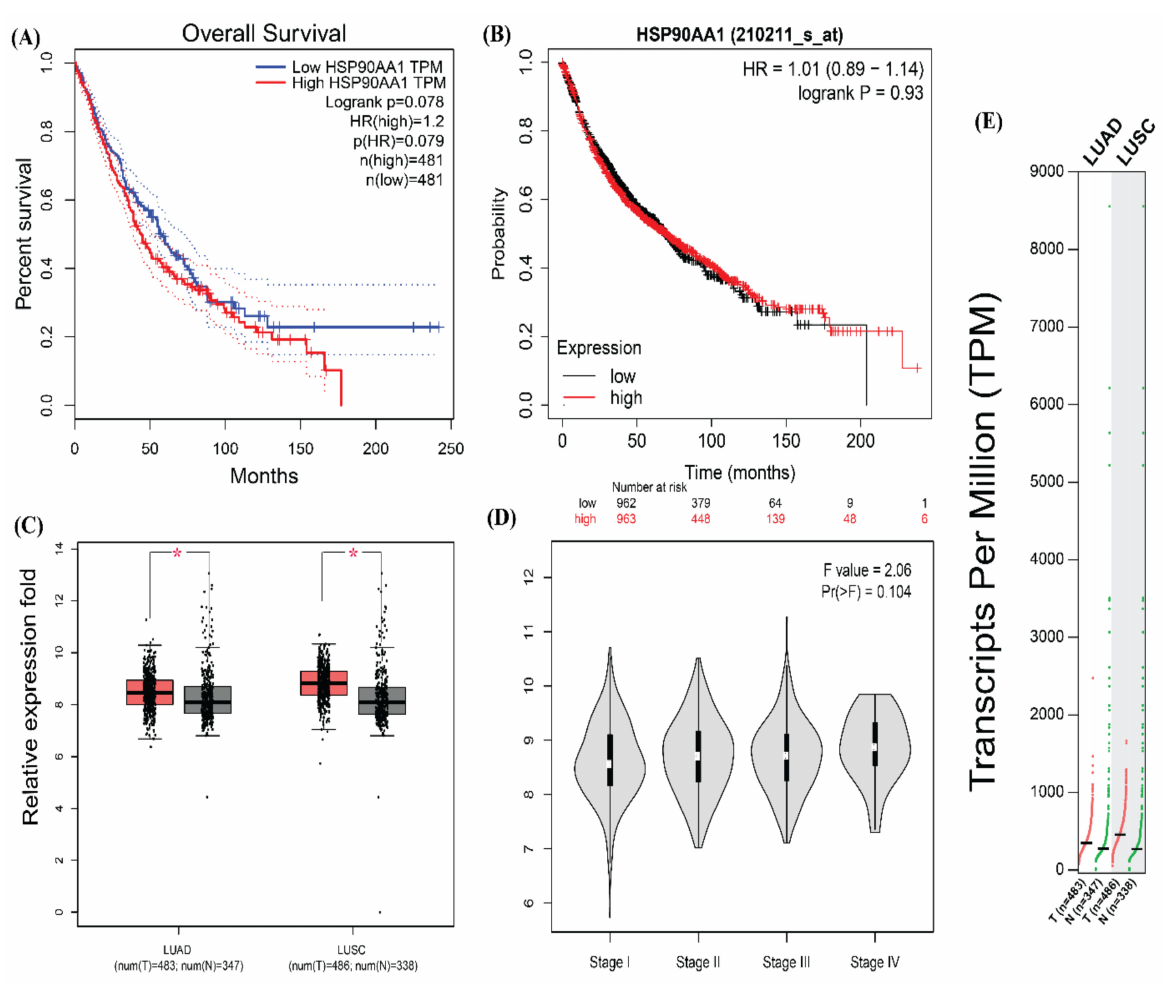
Figure 9. The survival, expressional and pathological analysis of HSP90AA1. ( A ) Survival plot for HSP90AA1 obtained from GEPIA (gepia.cancer-pku.cn). ( B ) Survival plot of HSP90AA1 from KM-Plotter. ( C ) Expression profile of HSP90AA1 in normal (grey) and tumor (red) samples of LUAD and LUSC datasets ( p < 0.05) ( D ) Pathological stage condition for HSP90AA1 genes using LUAD and LUSC datasets. ( E ) Expression of HSP90AA1 gene based on RNA-seq data from the TCGA database assessed by TPM (Transcripts per million) from GEPIA. (Survival analysis is done in GEPIA using log-rank test (Mantel–Cox test), for the hypothesis evaluation.) One * (star) signifies p value less than 0.05. It is updated in the text. One * (star) signifies p value less than 0.05. It is updated in the text.